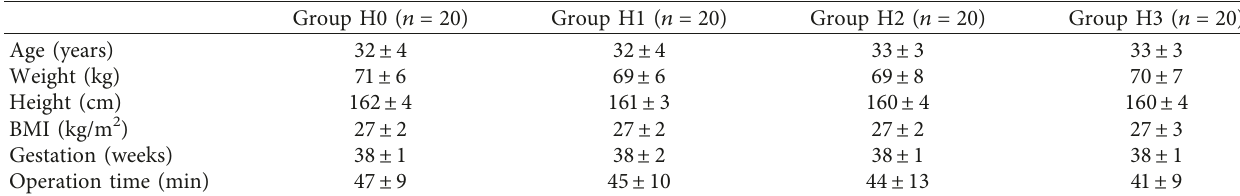
Table 1: Demographic and obstetric data.